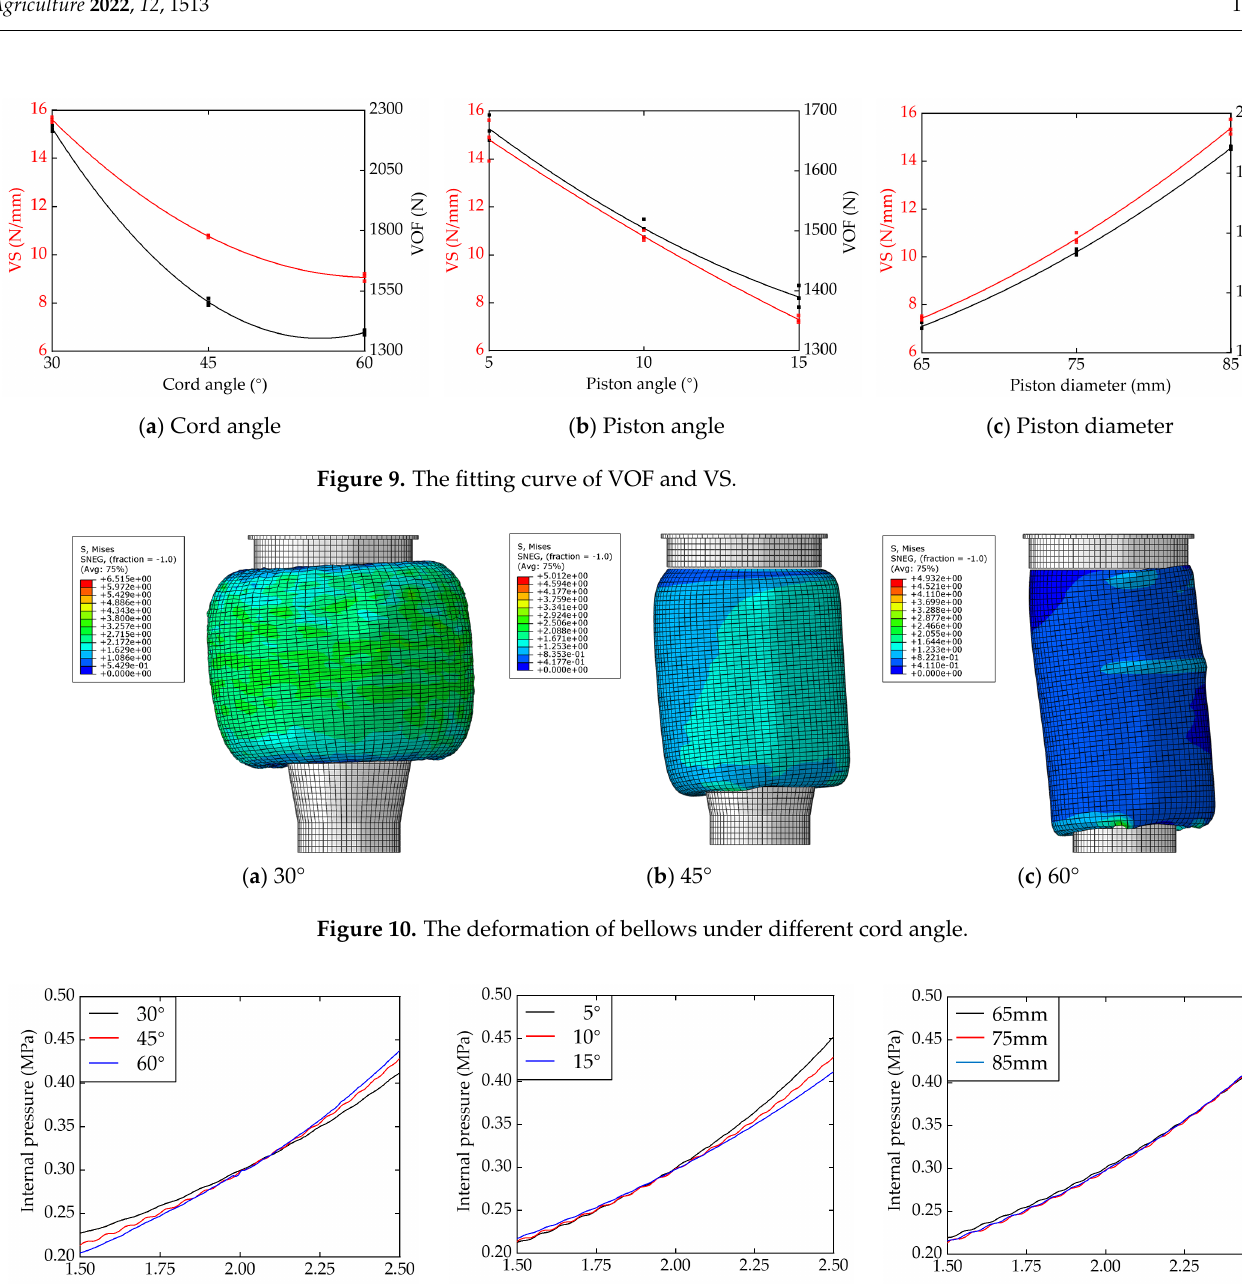
Figure 11. The internal pressure under different structural parameters.